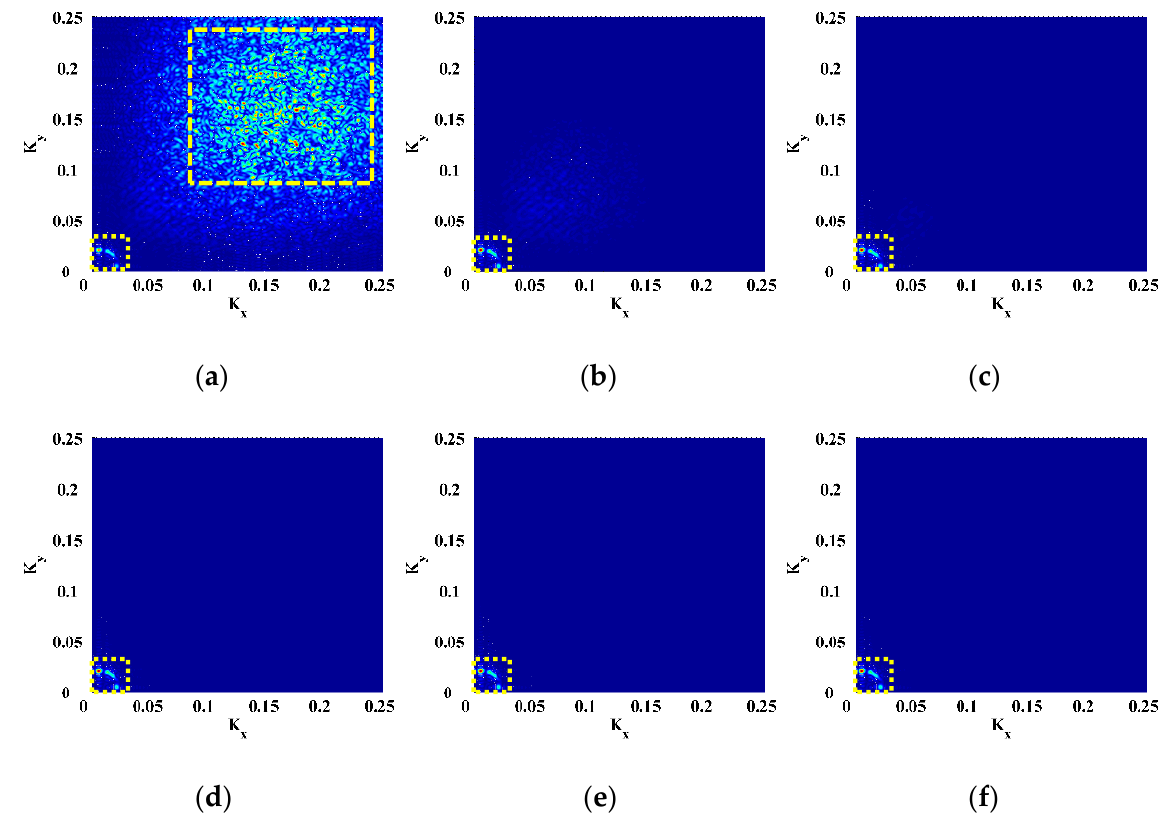
Figure 4. MDIs for Scenario V with scale parameters of ( a ) 2, ( b ) 4, ( c ) 6, ( d ) 8, ( e ) 10, and ( f ) 12.